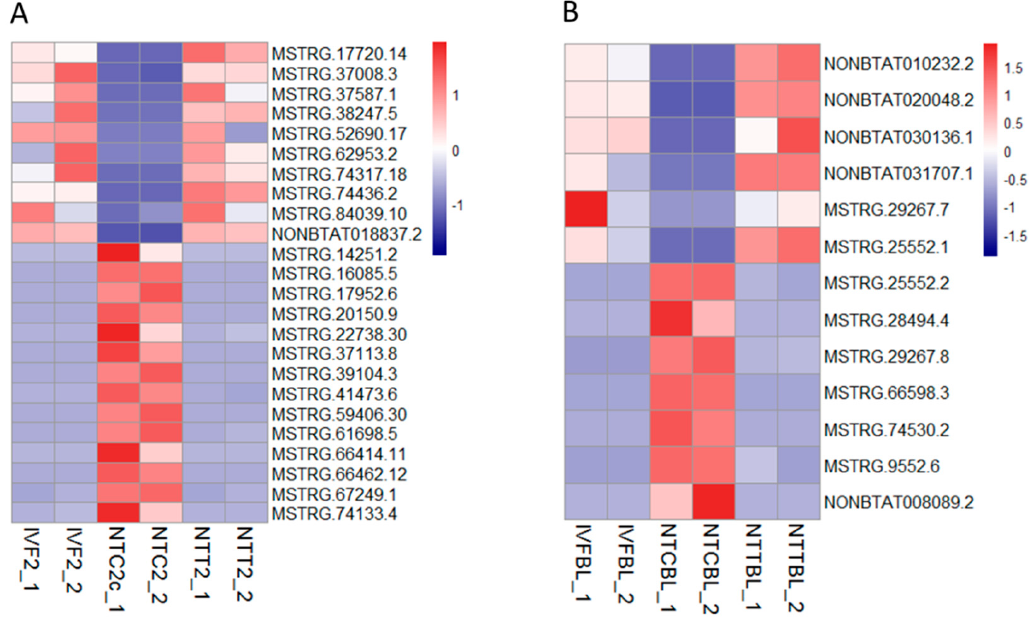
Figure 6. Restored lncRNA expression by Vc treatment in the cloned embryos. Heatmap illustration showing the lncRNAs that were restored by Vc treatment in the cloned embryos compared to their IVF counterparts. Di ff erentially expressed genes (DEGs) were analyzed under the conditions of q < 0.05, FC > 2, and FPKM > 1 in at least one of the three groups. ( A ) Restored lncRNAs in the two-cell stage. ( B ) Restored lncRNAs in the blastocyst